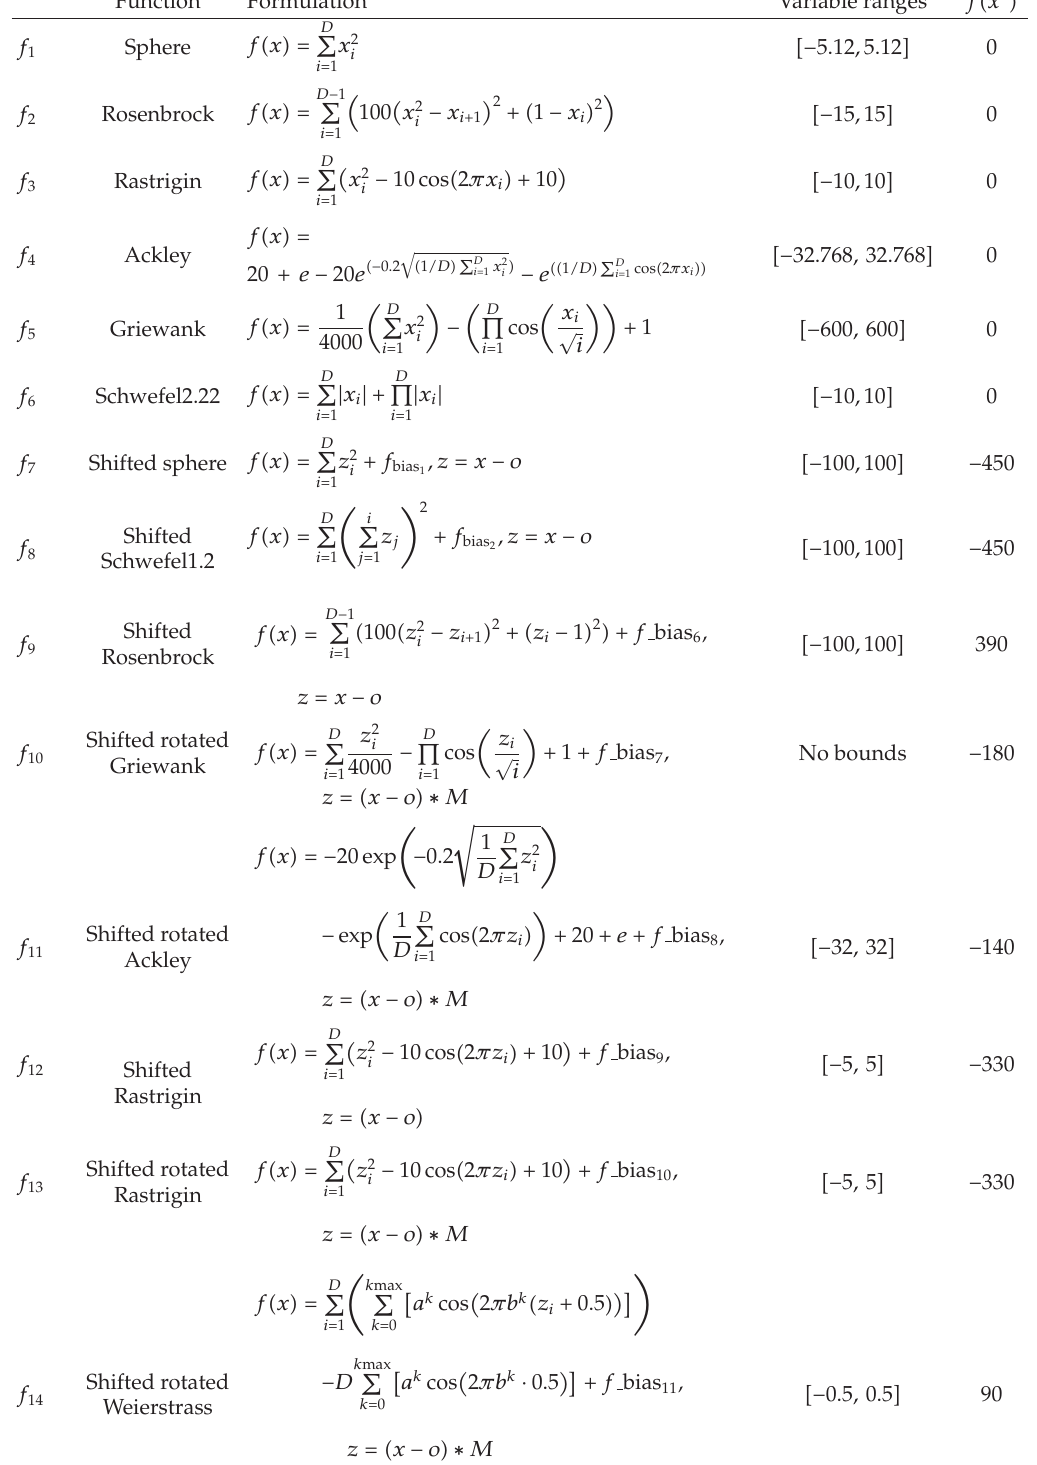
Table 1: Benchmark functions used in the experiment. Function Formulation Variable